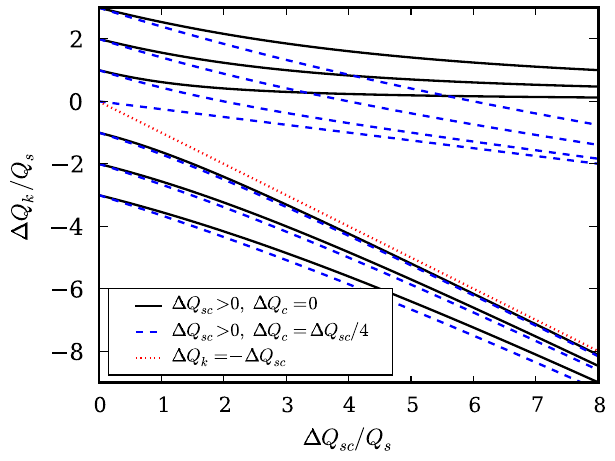
FIG. 2. (Color) Head-tail mode frequencies (cid:1) Q k as a function of the space charge tune shift (cid:1) Q sc . The solid black curves are for ¼ 0 . The dashed blue curves are for (cid:1) Q (cid:1) Q coh The dotted red curve indicates the space charge tune shift ¼ (cid:1) (cid:1) Q (cid:1) Q k sc .